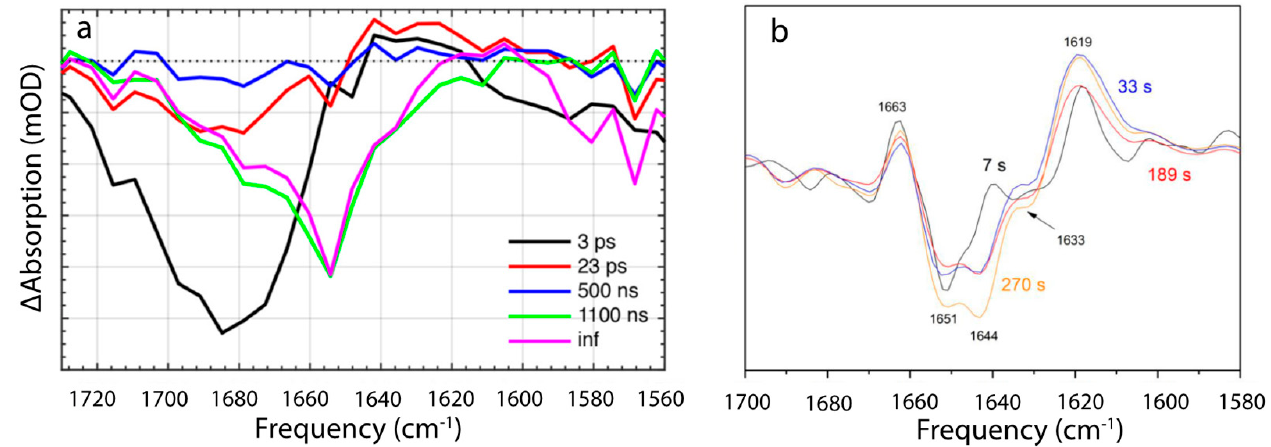
Figure 6. IR time-resolved signals of OCP photocycle [35,36]. ( a ) Evolution-associated difference spectra determined from global analysis of IR transient absorption data, where ps pulses were used to initiate the OCP photocycle. Reprinted with permission from [35]. Copyright© 2018 American Chemical Society. ( b ) FTIR difference spectra recorded during continuous illumination at different times after light onset. Reprinted with permission from [36]. Copyright© 2019 American Chemical Society.